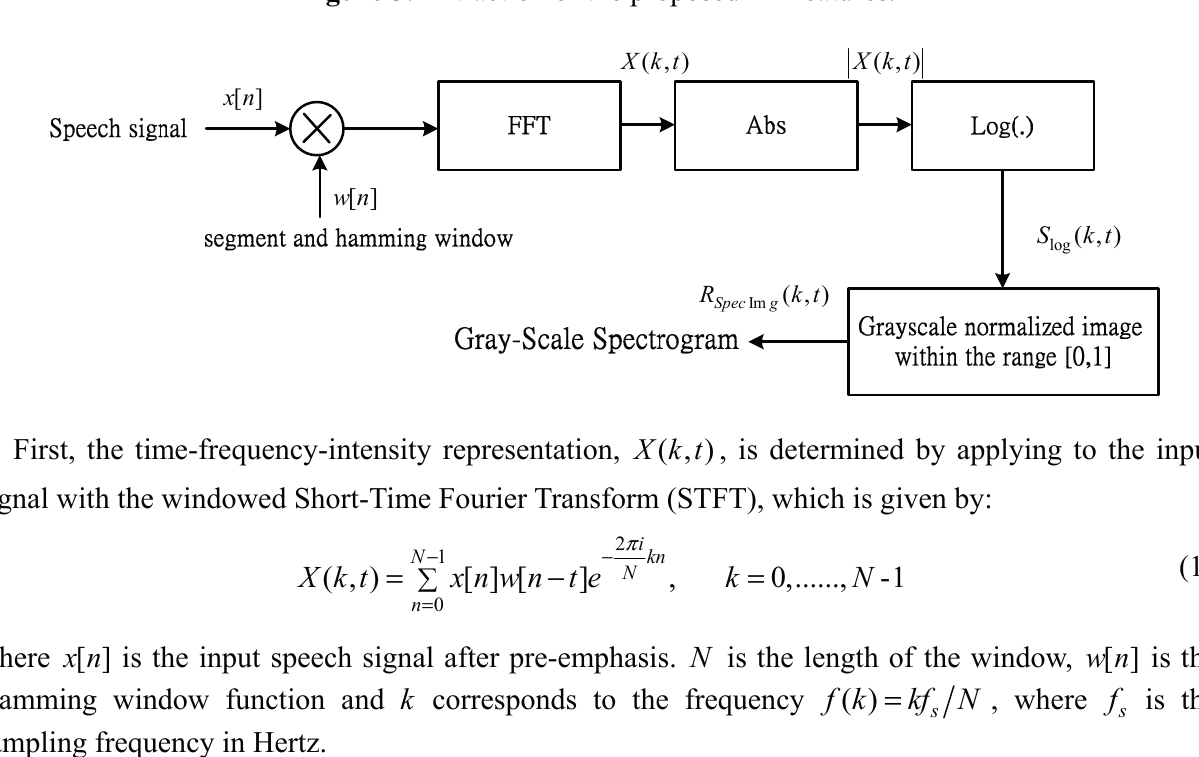
Figure 3. Extraction of the proposed TII